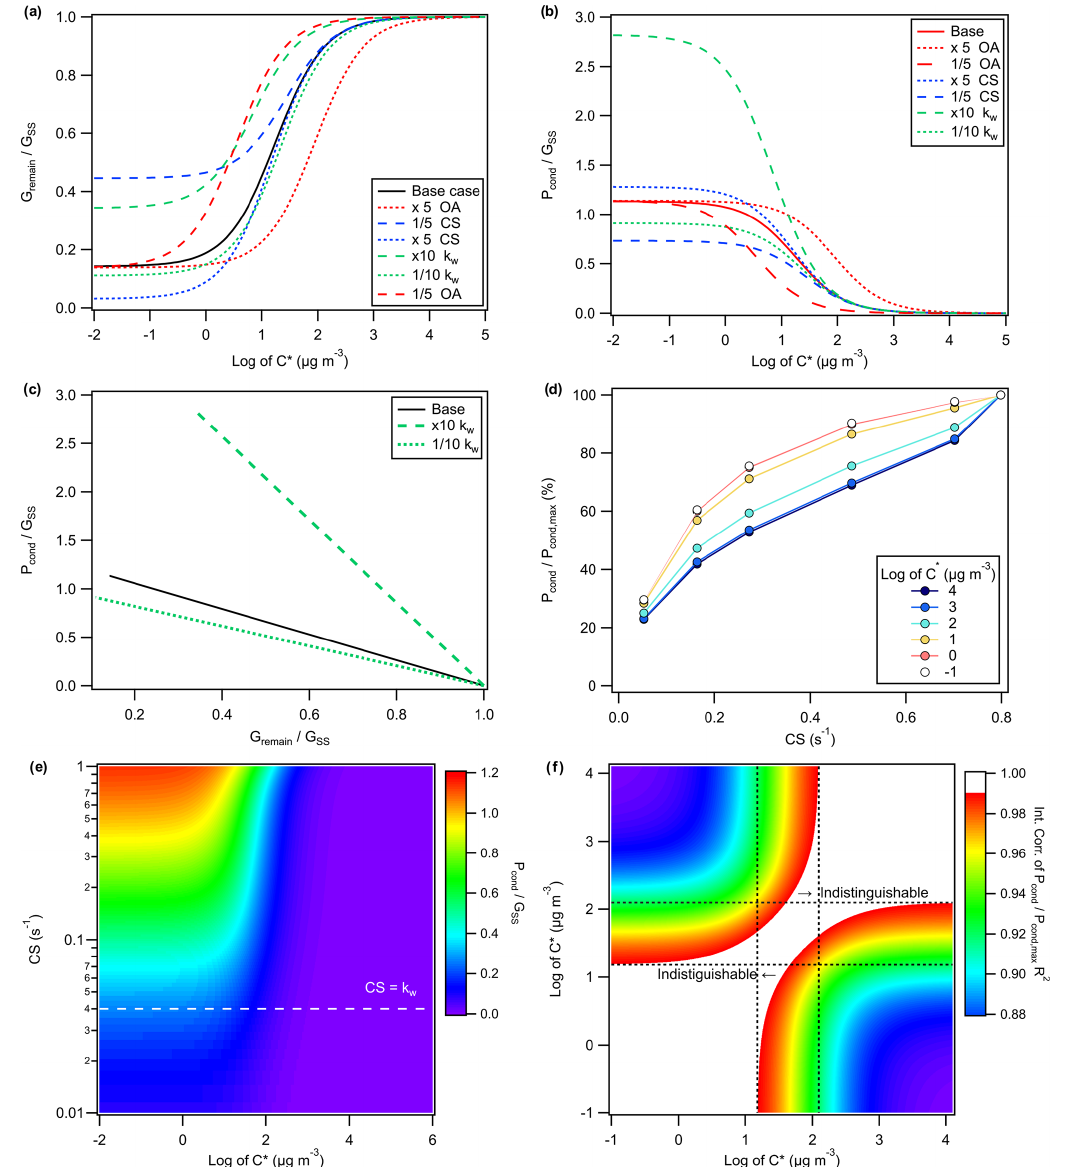
Figure 2. Modelled trend of the remaining gas-phase concentration, G remain , and the condensed vapour concentration, P cond , relative to the steady-state gas-phase concentration prior to seed injection, G SS , at various organic aerosol (OA) concentrations; condensation sinks (CSs); or assumptions of the wall loss rates, k w , for oxidation products of varying saturation vapour concentrations, C ∗ . Panel (a) shows the ratio of G remain to G SS as a function of log (C ∗ ) for the base case scenario of 20µgm − 3 for OA, 1s − 1 for the CS, and 0.04s − 1 for k w , as well as alternative scenarios. Compounds with log (C ∗ ) > 5 and < − 2 were modelled but not shown, as their trends are similar to that of compounds with log (C ∗ ) = 5 and − 2, respectively. Similarly, (b) shows the ratio of P cond to G SS as a function of log (C ∗ ) under various combinations of OA, the CS, and k w . Panel (c) shows the correlation of P cond /G SS and G remain /G SS , which is similar regardless of the C ∗ value, for different k w values. Panel (d) shows the trend of P cond , normalized to its maximum, for products of varying C ∗ as a function of the CS for k w = 0 . 04s − 1 . Compounds with log (C ∗ ) > 4 and < − 1 were modelled but not shown, as their trends are similar to those of compounds with log (C ∗ ) = 4 and − 1, respectively. The observed CS and OA from the TMB experiment are used to simulate the uptake trend shown in (d) , as opposed to the hypothetical conditions used for simulations shown in (a) – (c) . Panel (e) shows the modelled ratio of P cond to G SS for compounds of varying C ∗ under different CS and OA, which correlated roughly linearly with the CS, conditions. (f) The expected inter-correlation of the normalized P cond trends for compounds of varying log (C ∗ ) as a function of the CS for the TMB system, e.g. R 2 of pairwise linear regressions for traces shown in (d) or vertical slices in (e) . Regions with R 2 above 0.99 are considered unreliable for constraining C ∗ based solely on normalized P cond . The ratios of G remain and P cond to G SS , which are independent of the production rate, are used as dimensionless quantities instead of their absolute values for ease of